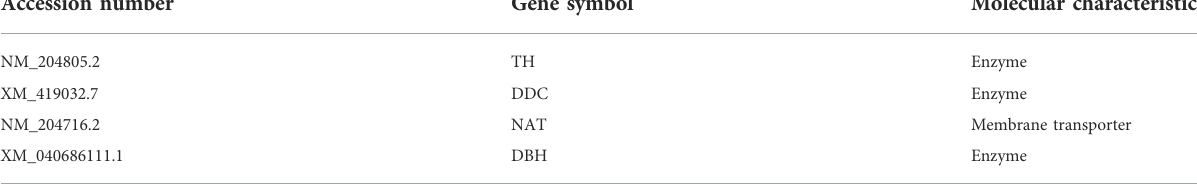
TABLE 1 Overview of dopaminergic and noradrenergic neuron-related gene probes used in this